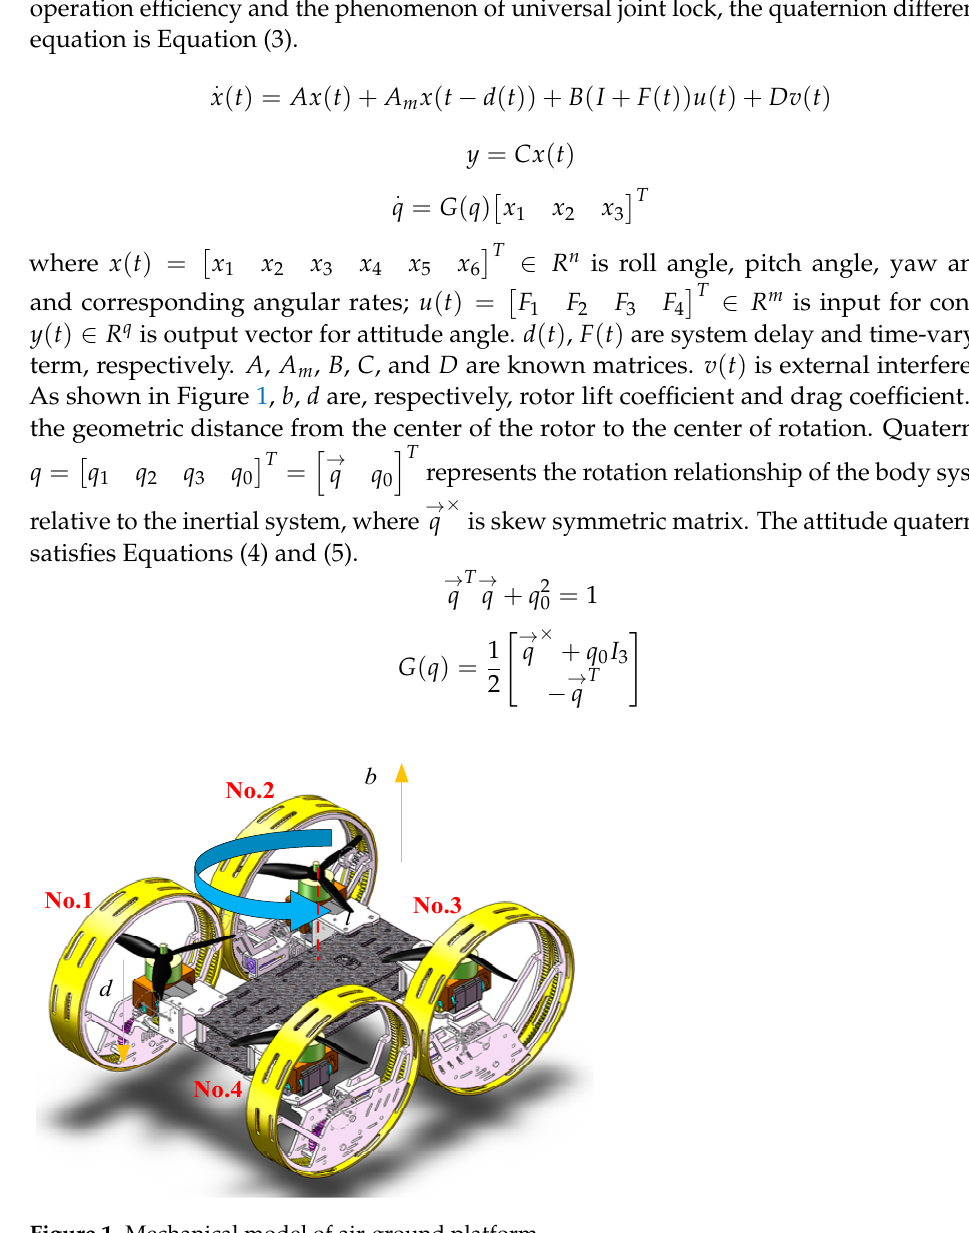
Figure 1. Mechanical model of air-ground platform.